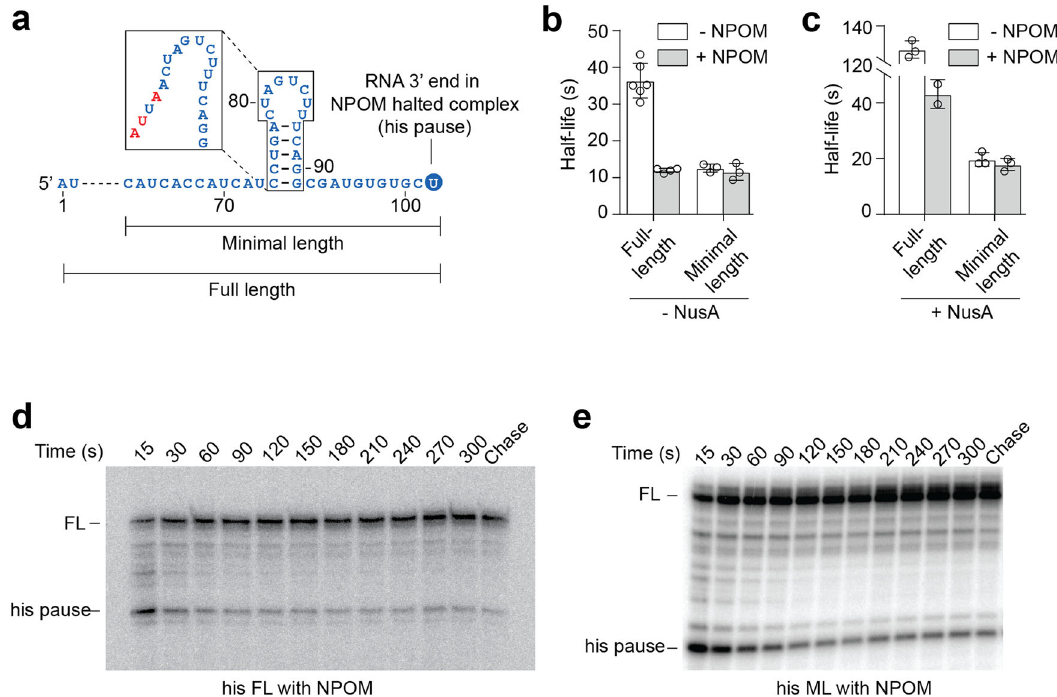
Fig. 4 EC synchronization at the pause site using NPOM allows observation of the his pause. a The different templates that were used allowed transcription of the entire his transcript (Full length, FL) or only a small section containing the pause hairpin (Minimal length, ML). b Observed half-life values of the his pause using the various constructs in the absence of NusA. The average values of independent experiments with standard deviations (SD) are shown. c Observed half-life values of the his pause using the various constructs in the presence of NusA. d Transcription kinetics experiment using the full-length (FL) his template with ECs synchronized at the his pause using a NPOM roadblock. e Transcription kinetics experiment using the minimal length (ML) his template with ECs synchronized at the his pause using a NPOM roadblock. The pause site and full-length species are shown. NPOM removal was performed in the absence of NTPs for panels ( d , e ). The experiments were performed at least two times and variations were less than